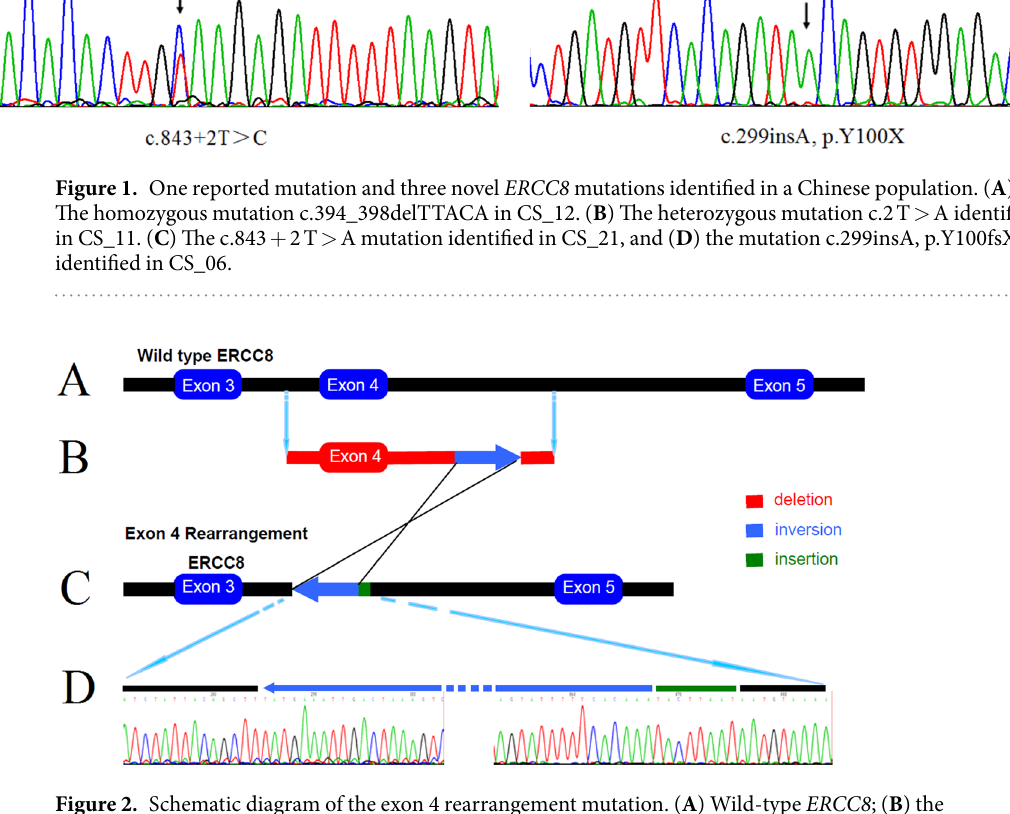
Figure 2. Schematic diagram of the exon 4 rearrangement mutation. ( A ) Wild-type ERCC8 ; ( B ) the affected genetic region. ( C ) The exon 4 rearrangement mutation in ERCC8 . ( D ) Sequence analysis of the two breakpoints. Note that the red bars show two deletions consisting of a 3368-bp region in exon 4 (c.275 + 703 to c.399 + 347) and a 555-bp region in intron 4 (c.399 + 2008 to c.399 + 2558). The blue arrow indicates the 1660- bp inversion region in intron 4 (c.399 + 348 to c.399 + 2007) and the green bar shows the 8-bp insertion at the 5 ′ end of breakpoint.